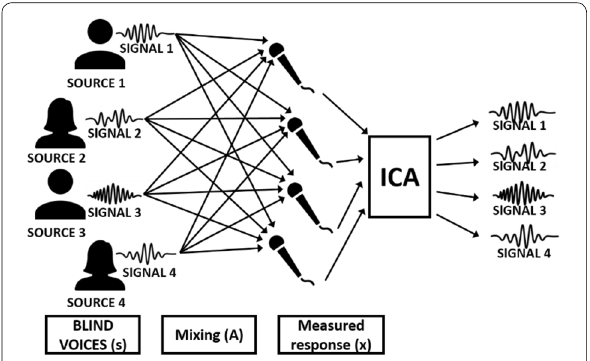
Fig. 1 The schematic drawing of the Cocktail party problem.